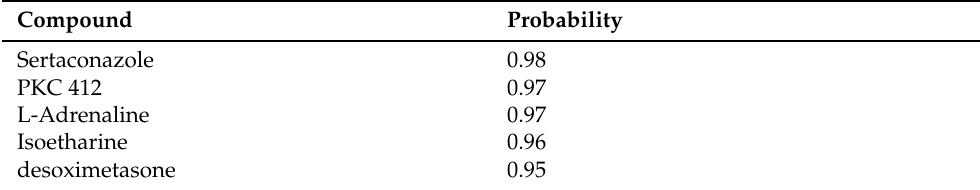
Table 4. List of Compounds with High Probability Scores (Classified as Active